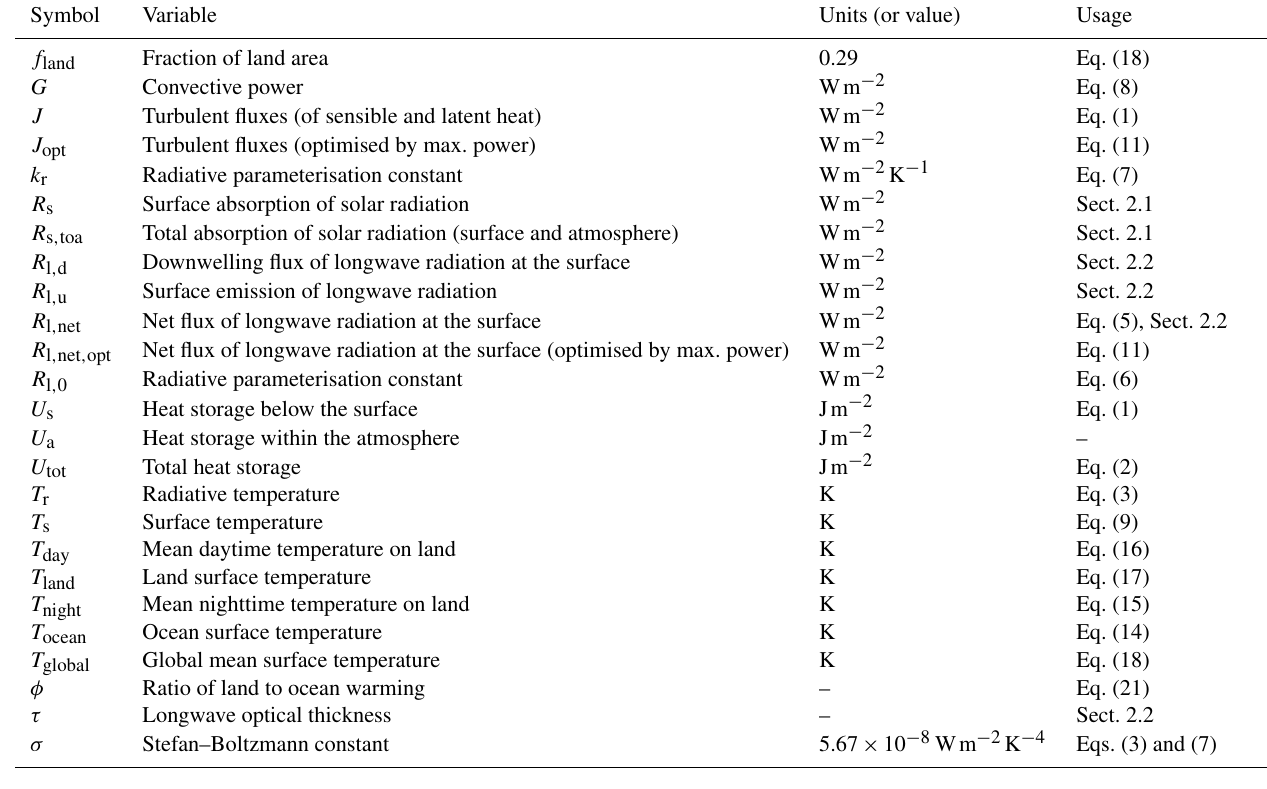
Table 1. Variables and parameters used in this study.